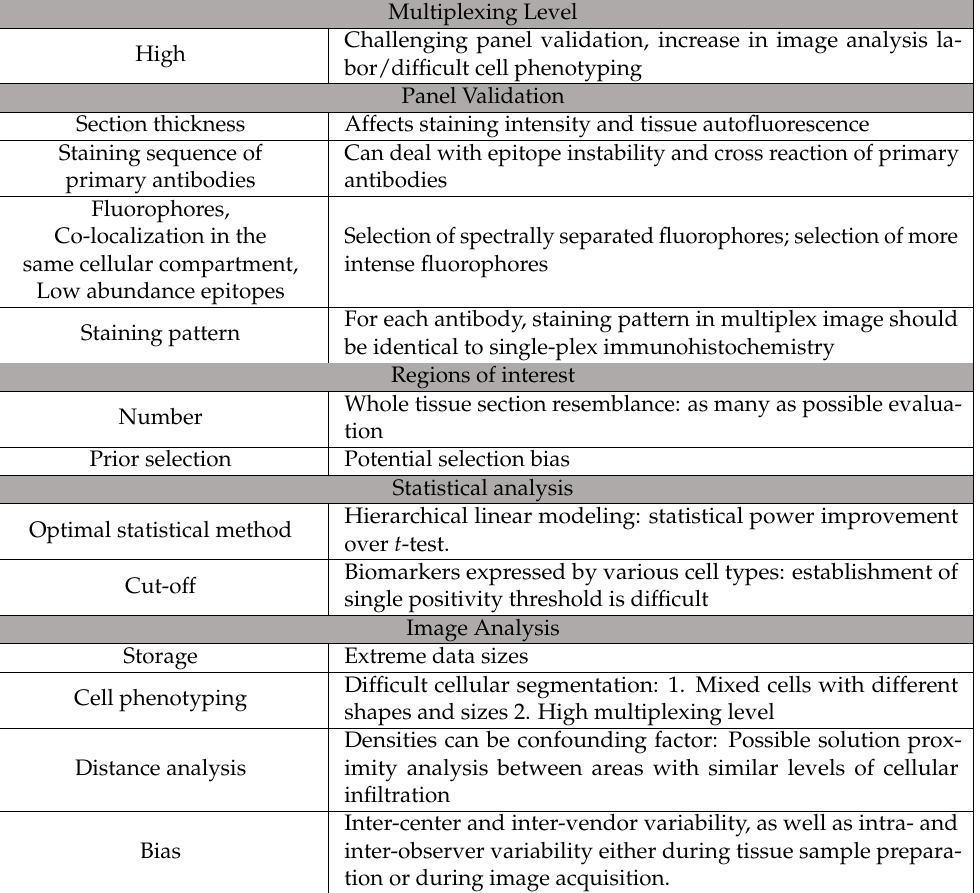
Table 4. Analytic challenges of multiplex in situ